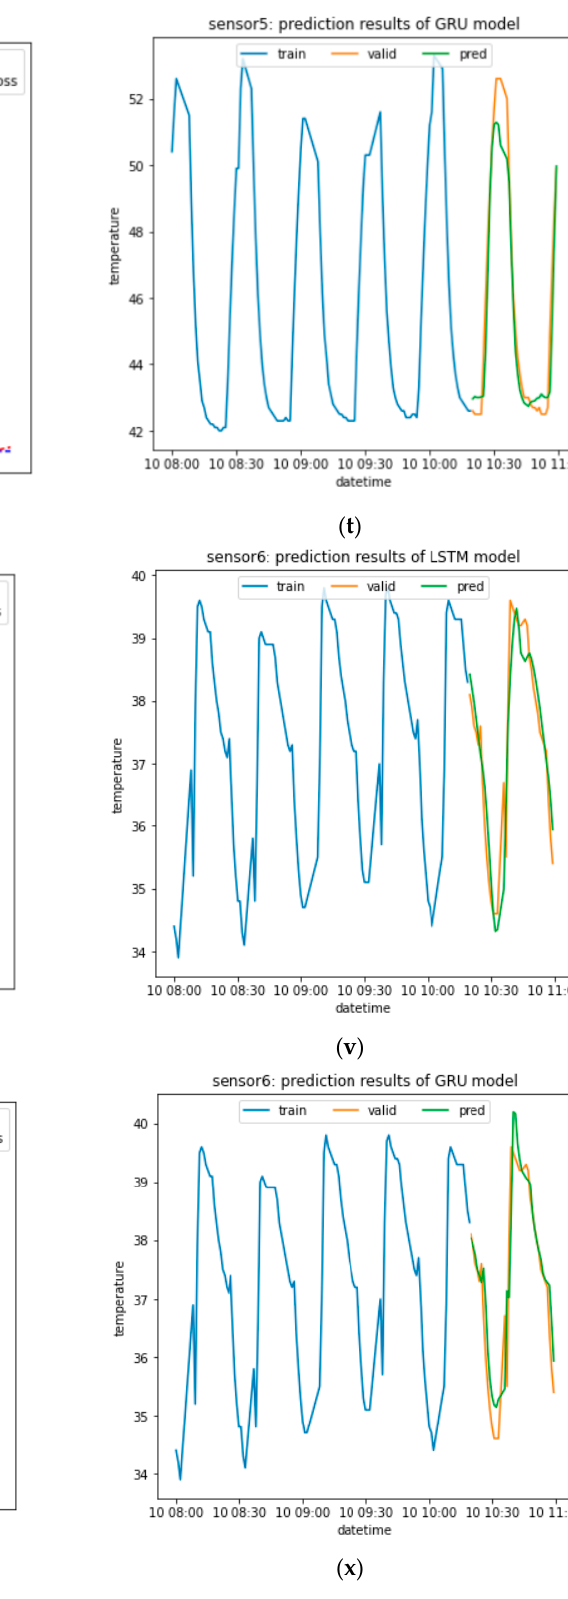
Figure 11. Comparison results of LSTM and GRU (( a – d ): loss function graph and prediction results graph of sensor1, ( e – h ): loss function graph and prediction results graph of sensor2, ( i – l ): loss